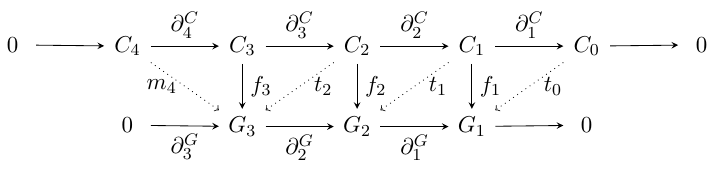
Figure 10 . Chain complexes for the 1 ; 2 ; 3-gauge